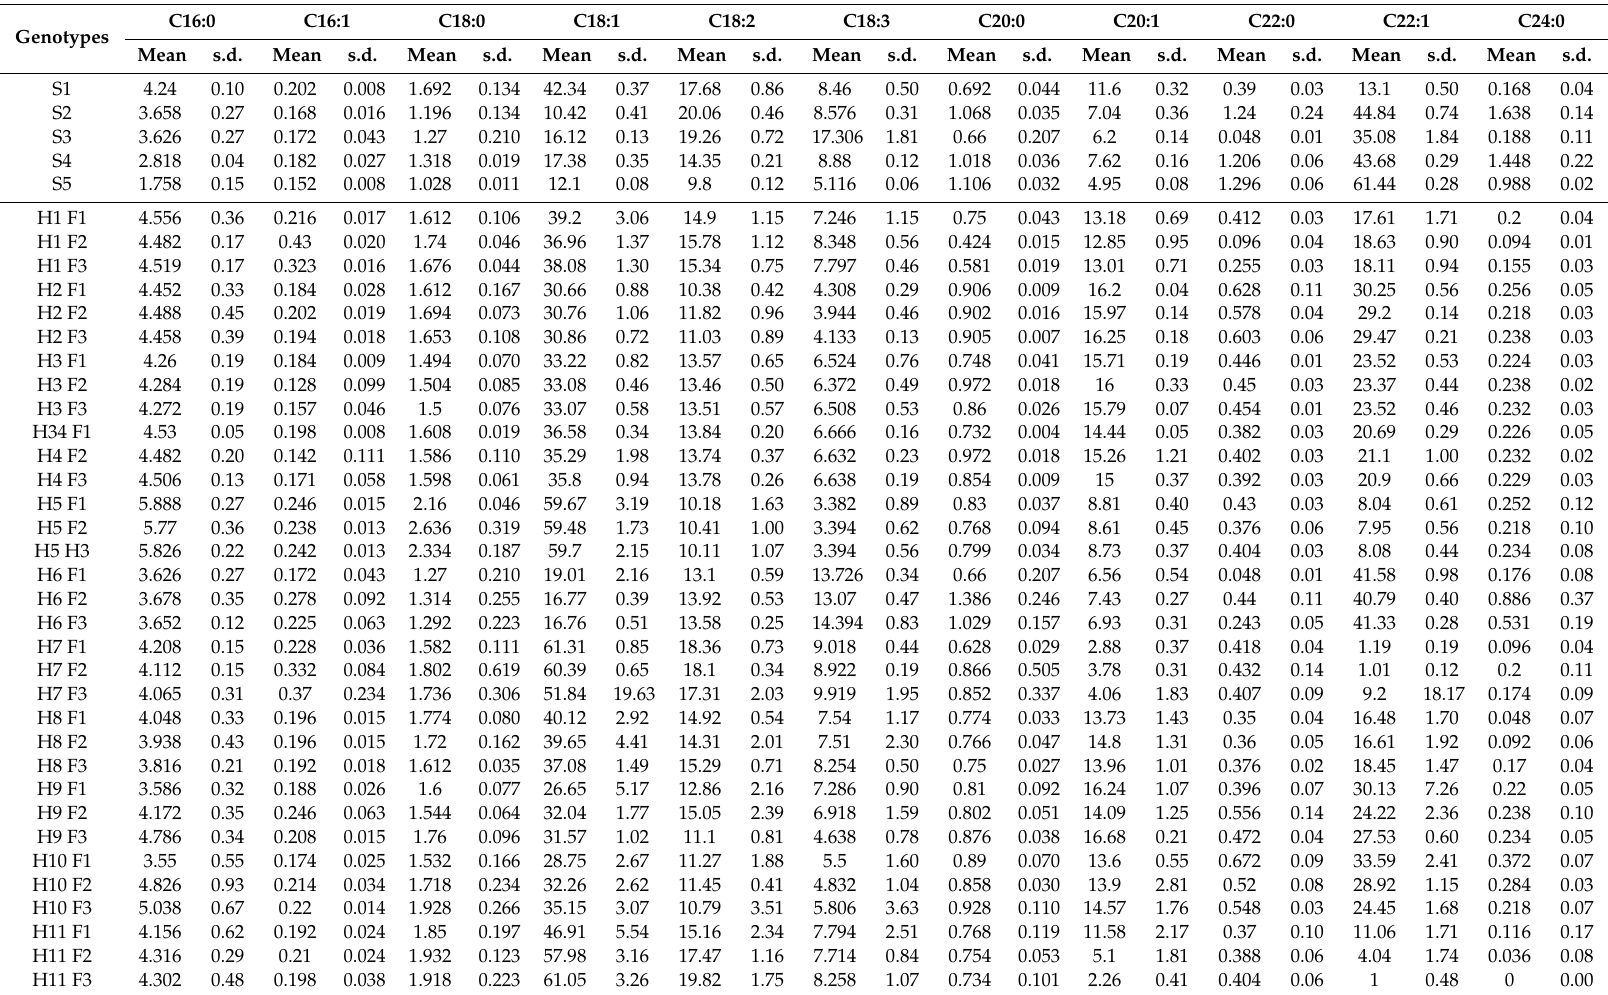
Table 3. Fatty acid profile (% of total identified, mean values ± SD) in analyzed Brassica